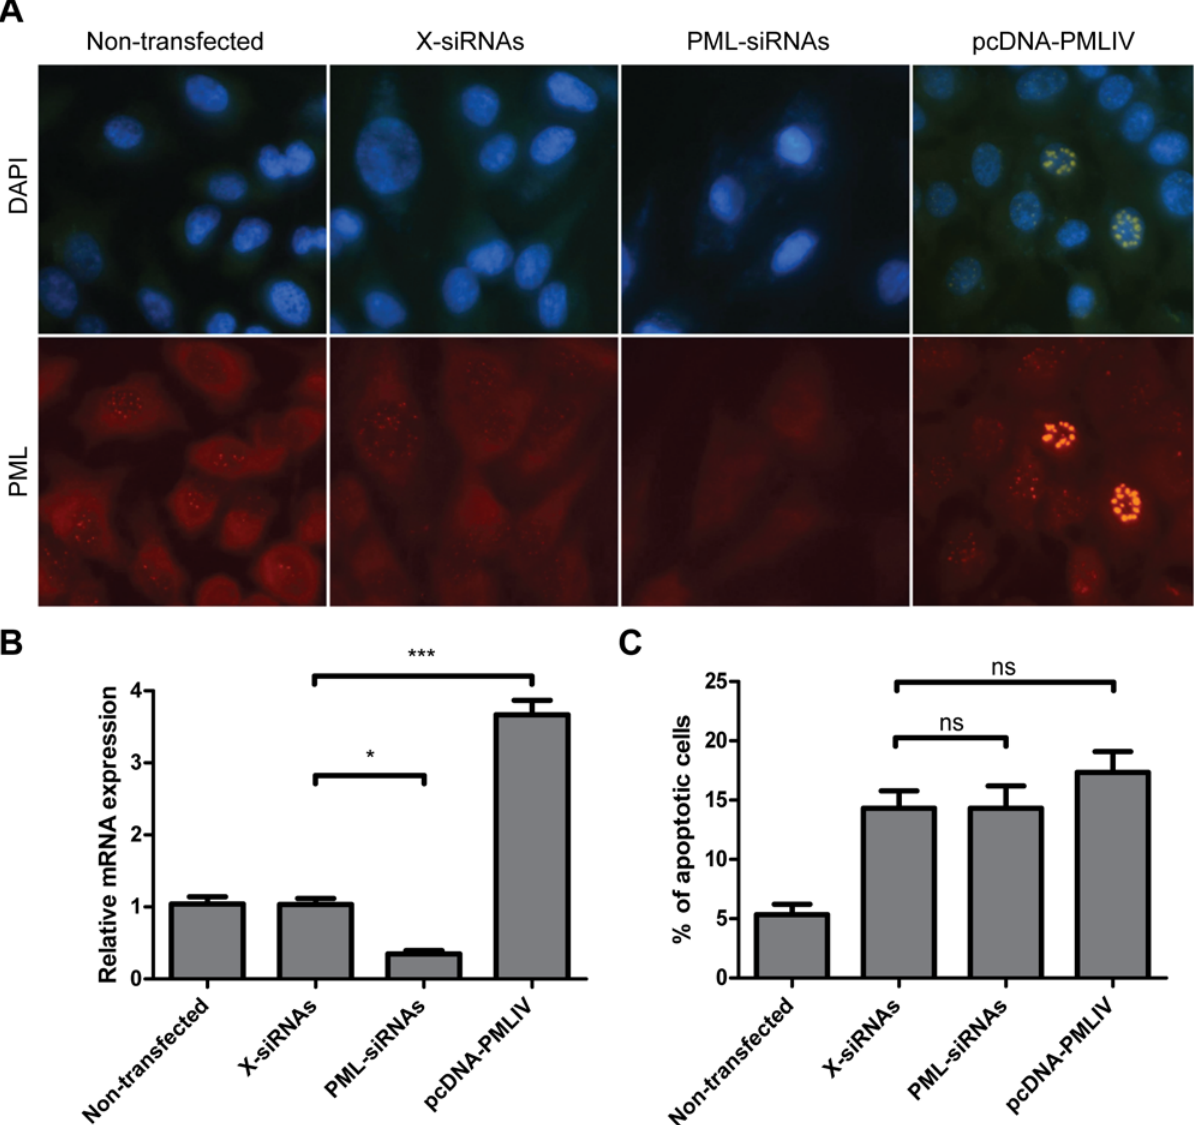
Fig 1. Assessment of PML silencing and overexpression in A549 cells. A549 cells were non-transfected, transfected with X-siRNAs, PML-siRNAs or pcDNA-PMLIV. (A) At 24 h post transfection, cells were fixed and PML protein was stained using anti-PML monoclonal antibody and TRITC-labeled anti- mouse IgG. Cells were visualized by fluorescence microscopy. Magnification: 400 X. (B) In parallel, cells were harvested for determination of PML-mRNA expression levels by real time PCR. PML-mRNA expression level is represented as fold difference relative to X-siRNAs-transfected cells and normalized to β -actin-mRNA. The reported values are mean ± SD (n = 3). Asterisks indicate a significant difference ( *** p < 0.001; ** p < 0.01; * p < 0.05). (C) Counts of apoptotic cells and apoptotic bodies were performed using 400 X magnification. All identified apoptosis in the sample were counted and the % of apoptotic cells was defined as the total number of apoptotic cells and apoptotic bodies in at least 500